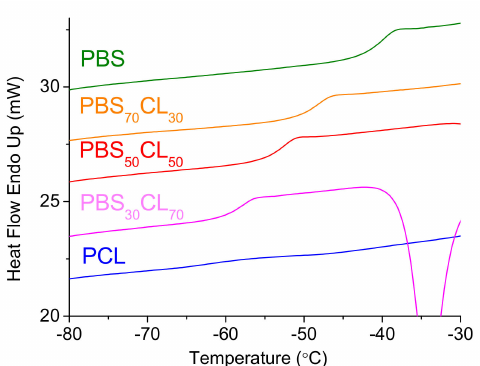
Figure 8. DSC traces of melt-quenched of PBS, PCL, and PBS x CL y copolyesters showing the glass transition